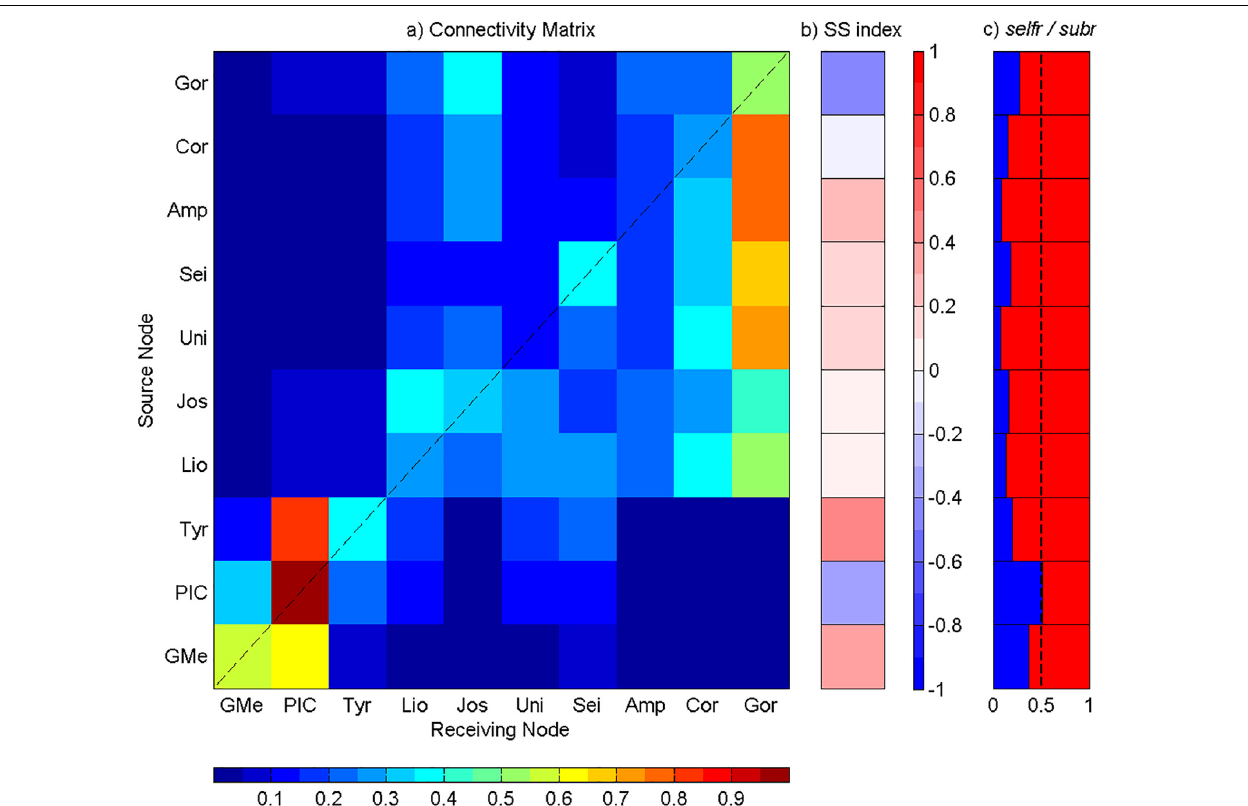
FIGURE 7 | Analysis of the connectivity among Great Meteor and Madeira-Tore complexes at the depth range of 300 to 500 m. (a) Connectivity matrix between the seamounts: GMe – Great Meteor; PIC – Plateau, Irving, and Cruiser; Tyr – Tyro; Lio – Lion; Jos – Josephine; Uni – Unicorn; Sei – Seine; Amp – Ampere; Cor – Coral; and Gor – Gorringe. The y -axis represents seamounts acting as sources and the x -axis represents seamounts acting as sinks. The connectivity degree increases from blue to red. (b) Source–sink indices for each seamount. (c) Self-recruitment ( selfr , blue color) and subsidy-recruitment ( subr , red color) fractions for each seamount. The dashed line corresponds to the reference value of